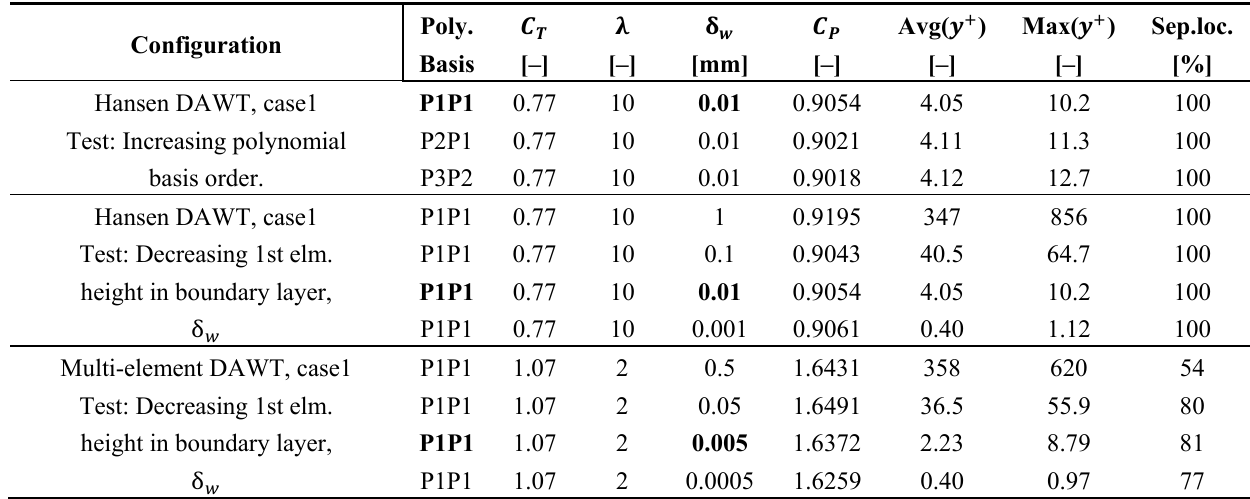
Table 2. Mesh/discretization independency test